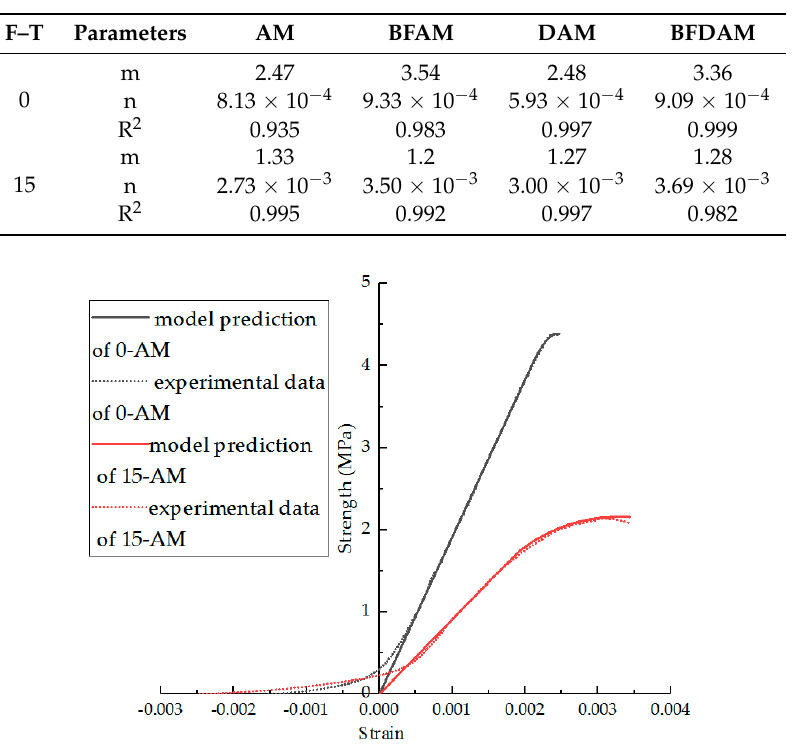
Table 6. The parameters of the model.